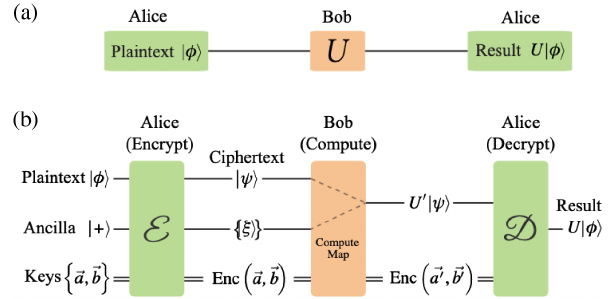
FIG. 5. Diagram of our QFHE scheme. (a) The intended computation U performed by Bob directly on plaintext j ϕ i . (b) The same computation U performed via QFHE. Here E and D are encryption and decryption operations. The computational map performed by Bob is a quantum channel that depends on the intended computation on U , and consumes some ancillas j ξ i in the process. Classically homomorphically encrypted Pauli keys ⃗ b Enc ð ⃗ a; Þ are modified along the way. Alice decrypts Enc ð ⃗ a; which allows her to decrypt j ψ i and obtain the desired output U j ϕ i .